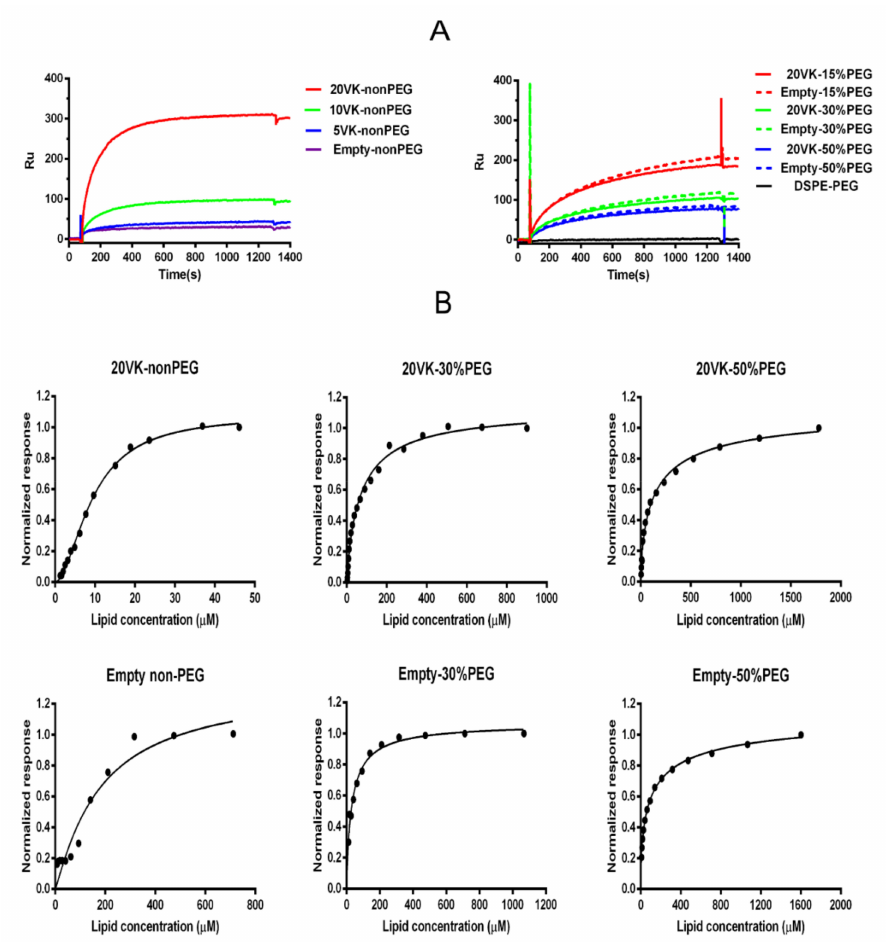
Figure 5. SPR analysis of the binding of mixed micelles to SR-B1, with varying vitamin K content (mg of VK) and PEG density (% of EPC replaced by DSPE-PEG). ( A ) Binding response of mixed micelles (non-PEG, 15%, 30% and 50%-PEG, with and without vitamin K, with empty DSPE-PEG micelle as control) at a lipid concentration of 36 µ M. ( B ) Dose-response curves of serial dilutions of mixed micelles, expressed as total lipid concentration, normalized by the maximal response signal at